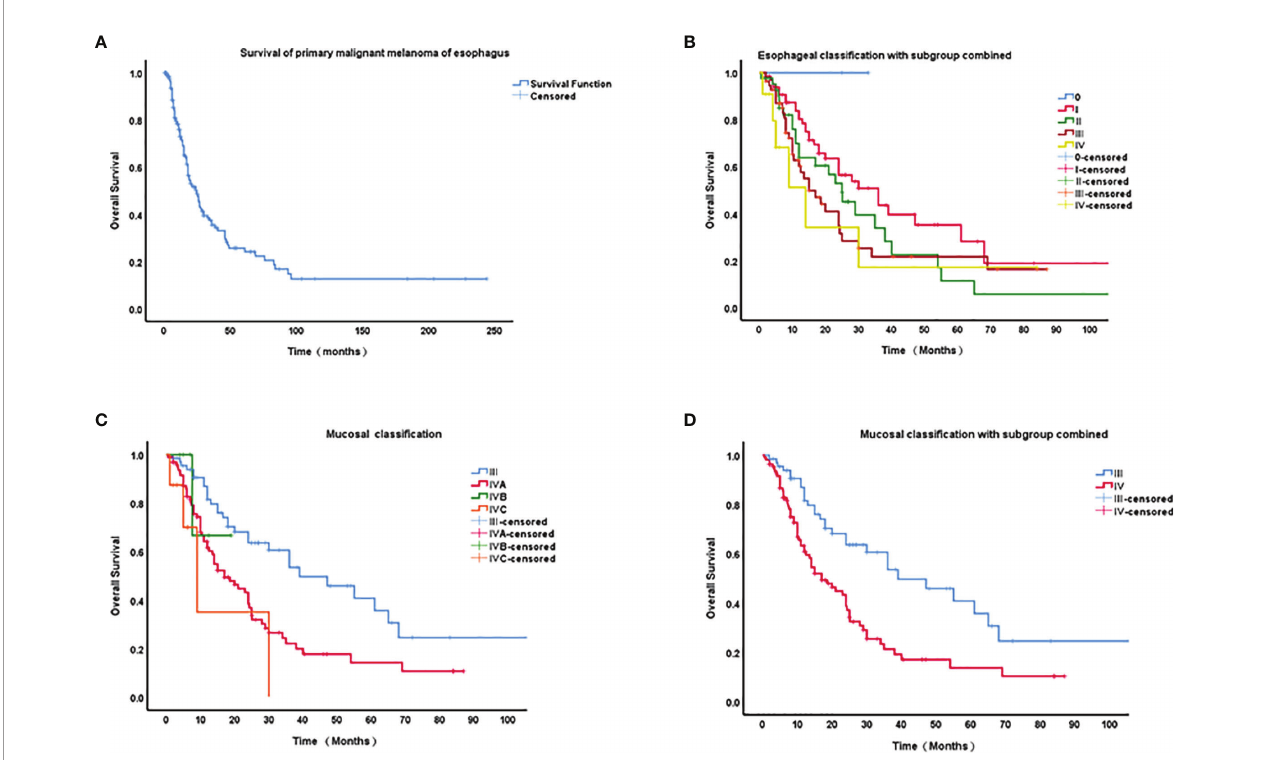
FIGURE 2 | Kaplan – Meier curves of survival of primary malignant melanoma of esophagus (PMME) and different staging classi fi cations for PMME patients. (A) survival of 182 cases with PMME; (B) The 8th AJCC classi fi cations of esophageal carcinoma for PMMEs. (C) The 8th AJCC classi fi cations of mucosal melanoma. (D) Mucosal classi fi cation with IVB and IVC integrated into IVA.